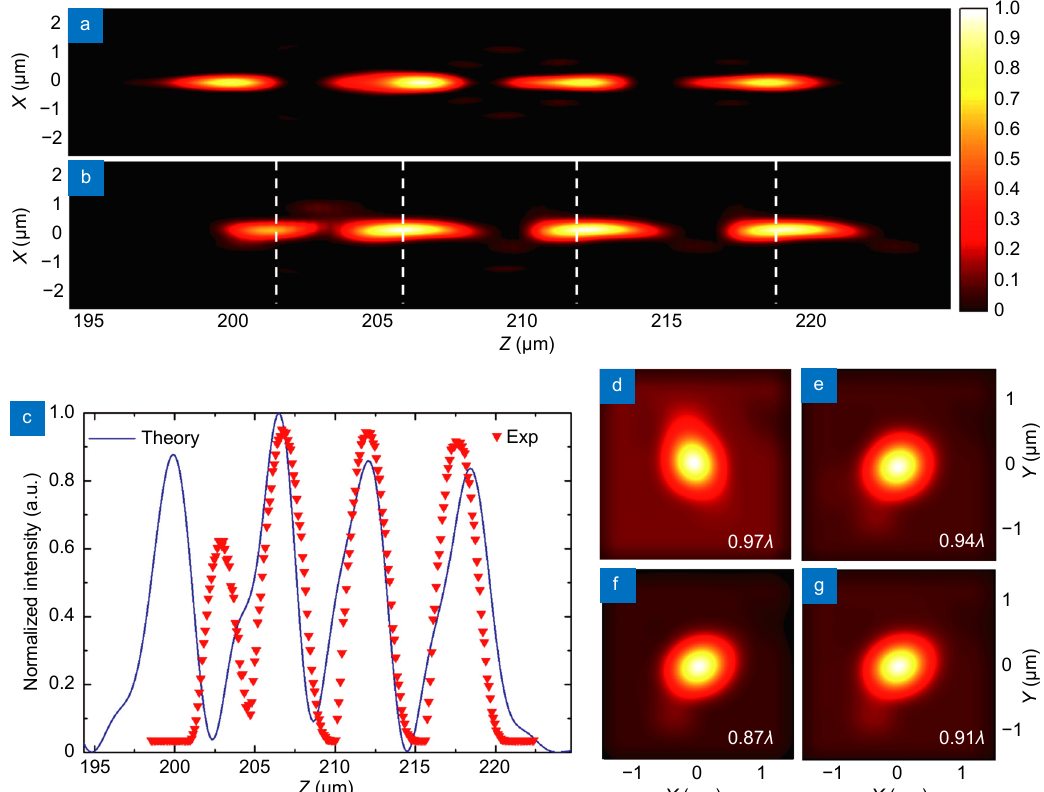
Fig. 4 | Focusing characterization of axial multifocal spots GO metalens. ( a ), ( b ) Normalized intensity distributions in the x-z plane from the- oretical calculation and experiments, respectively. ( c ) Theoretical and experimental normalized intensity plots along the optical axial in the focal region. ( d )−( g ) Normalized intensity distributions at positions marked by the dashed lines shown in (b), the axial positions are 202 μm, 206 μm, 212 μm, 218 μm. The lateral FWHMs at these positions are 0.97 λ , 0.94 λ , 0.87 λ , 0.91 λ